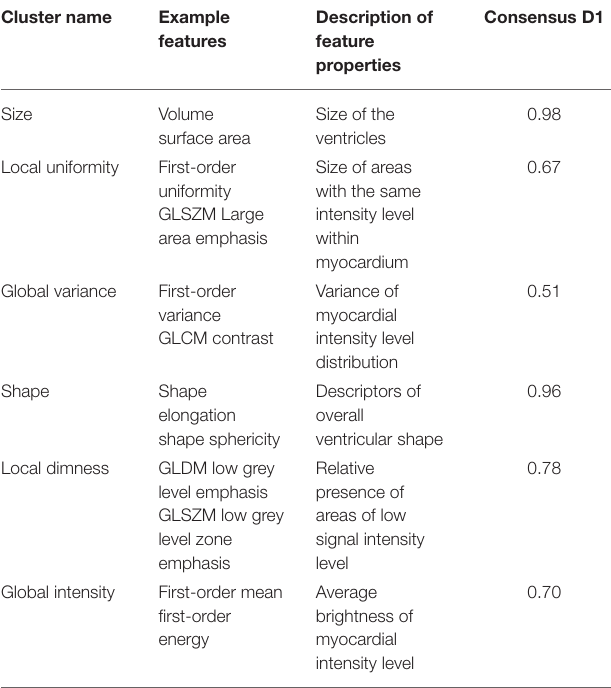
TABLE 1 | Summary of the six defined radiomics feature clusters including their assigned names, example features, and properties represented by the features within each